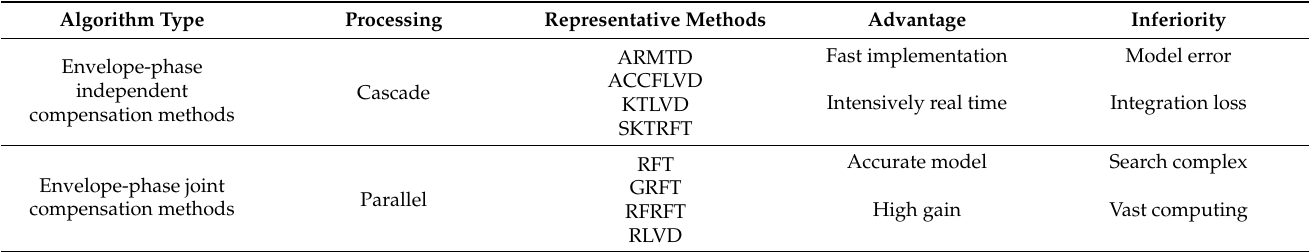
Table 1. Classification and characteristics of long-time coherent integration